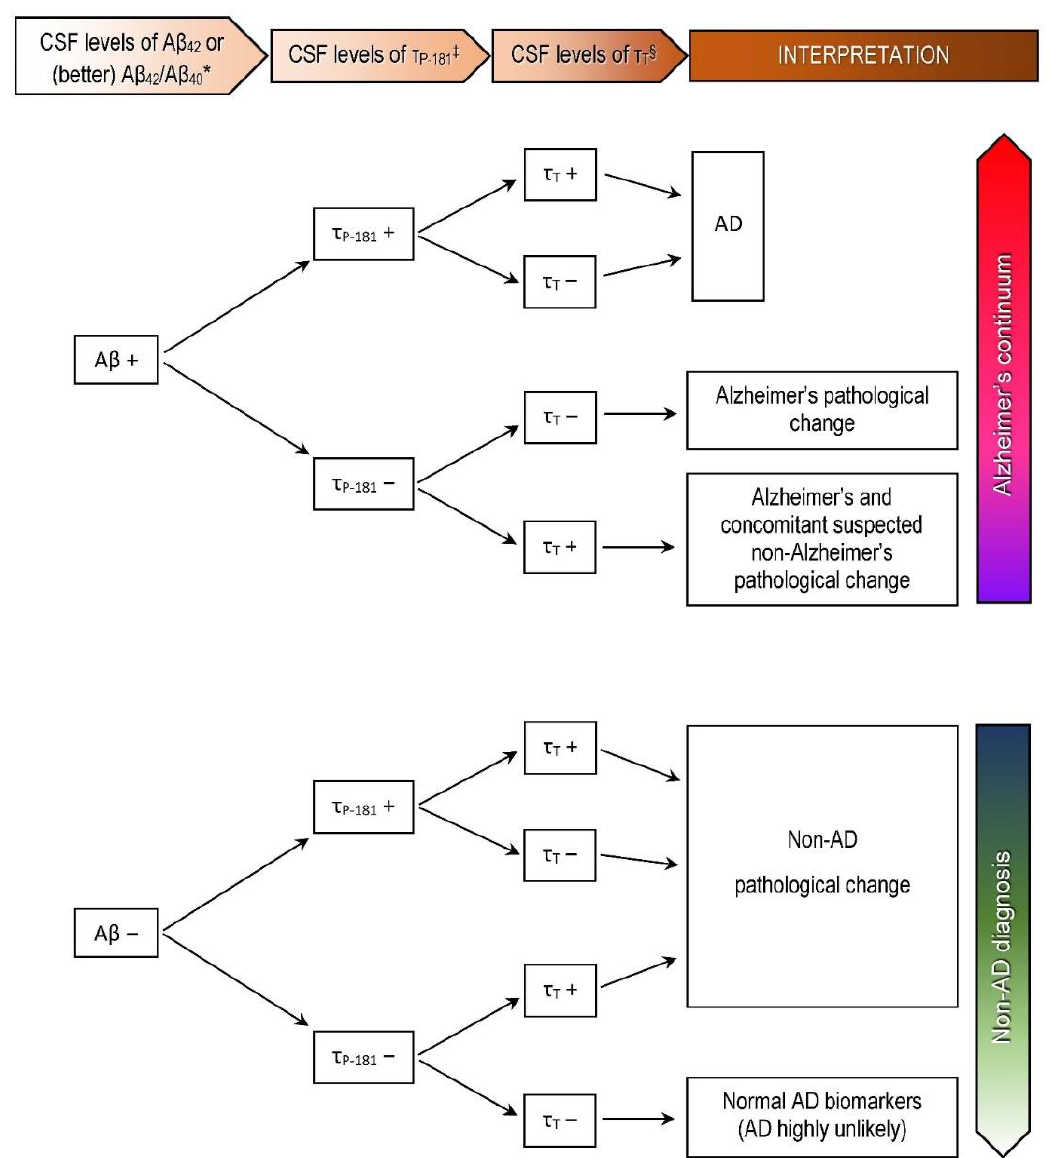
Figure 1. Biomarker levels in the CSF and interpretation of results for clinical purposes in our departments according to the AT(N) classification system, using the classical CSF biomarkers and structural imaging (MRI or CT) [18]. * Abnormal have decreased levels (positive result). ‡ Abnormal have increased levels (positive result). § Abnormal have increased CSF levels or atrophy in structural neuroimaging (positive result). Negative results indicate normal findings. AD: Alzheimer’s disease.